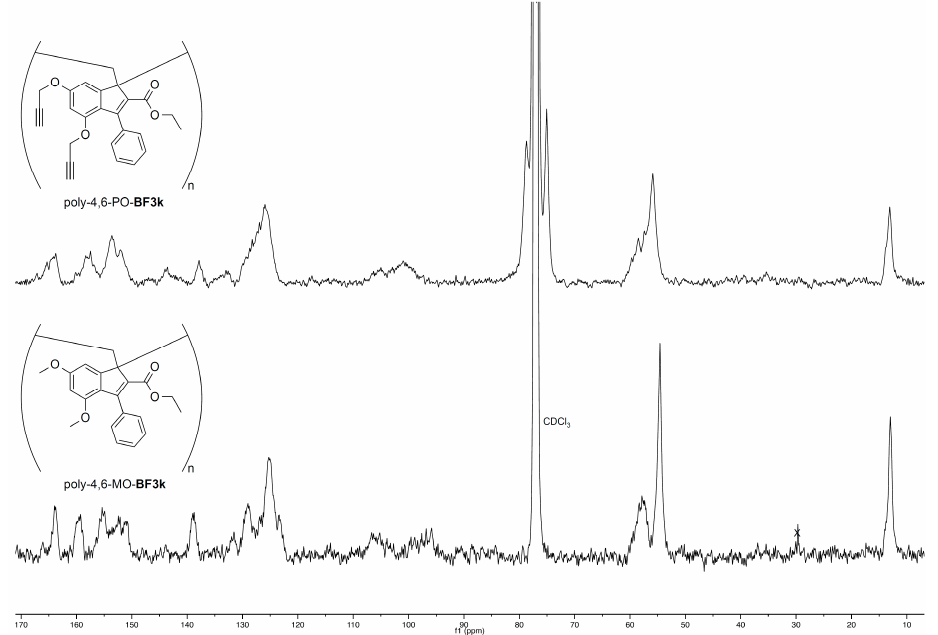
Figure 8. 13 C NMR spectrum (CDCl 3 ) of poly-4,6-PO- BF3k (top trace) compared with that of previously reported poly-4,6-MO- BF3k (bottom trace).